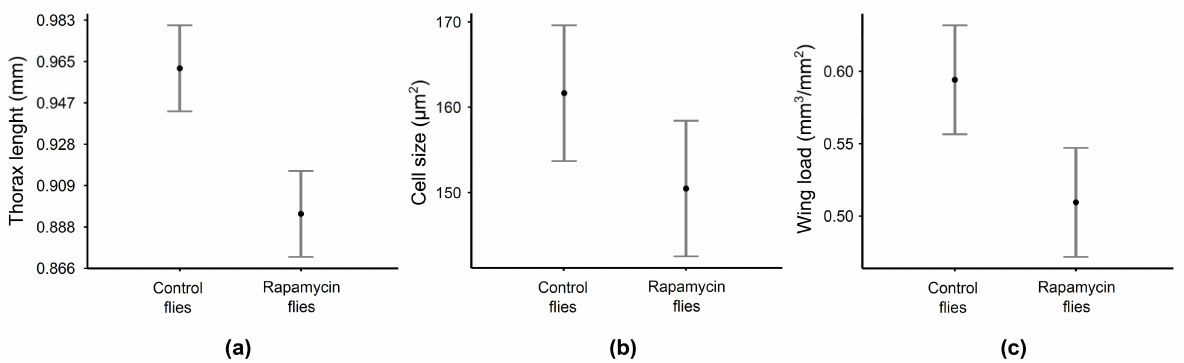
Figure 2. Adult males of D. melanogaster that developed on food supplemented with rapamycin (rapamycin flies) had smaller thoraxes ( a ), smaller wing epidermal cells ( b ) and a lower wing load ( c ) than flies that developed on standard food (control flies). The graphs show means with 95% confidence intervals estimated from a statistical model. Data on thorax length were transformed back to the original values for the purpose of generating this graph to make it easier to read the actual